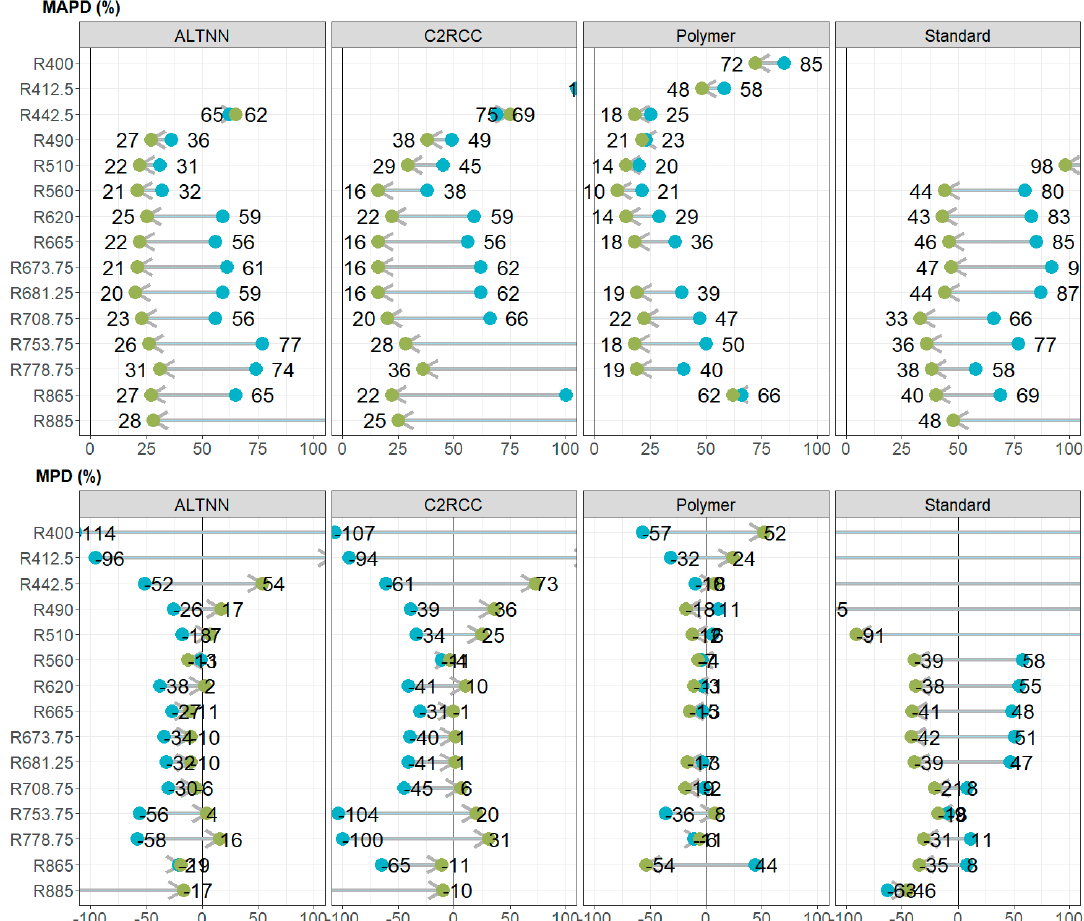
Figure 7. Change in the accuracy of AC processors retrievals on all match-up data (blue dots) and after filtering the in situ data based on the 5% uncertainty threshold at least in one band. The number of match-up points for all data and after filtering: POLYMER (41 → 24), Case 2 Regional CoastColor (C2RCC) (27 → 15), Alternative Neural Net (ALTNN) (29 → 17), Standard L2 (49 → 26). The limits for the x -axis have been set to ±